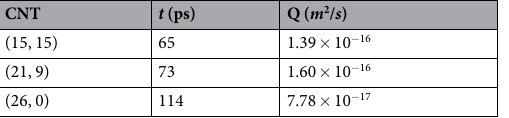
Table 2. The filling time and volumetric flow rate into considered